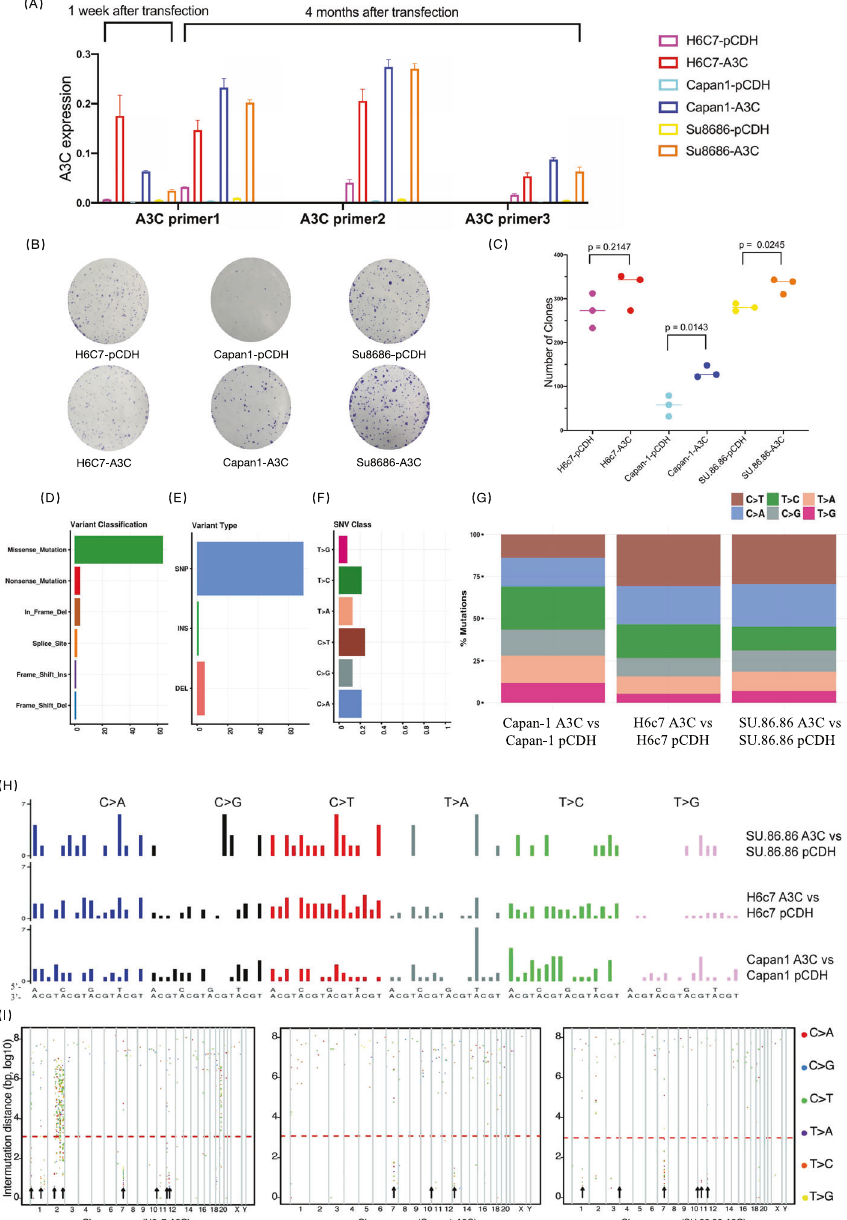
Fig. 4 Transfection of pCDH-APOBEC3C into pancreatic cell lines causes characteristic genomic alterations. A APOBEC3C-overexpressing cell lines were generated by transfecting a pCDH plasmid loaded with the APOBEC3C CCDS, and the control group was transfected with the pCDH backbone plasmid. Multiple APOBEC3C primer pairs were applied to perform qRT – PCR in triplicate at different time points after transfection to validate that the cell lines transfected with the pCDH-A3C plasmid had a steadily elevated APOBEC3C mRNA expression level compared to the corresponding control cell lines. The corresponding western blotting results are shown in Fig. S4. B Representative images of the clonogenic assay. The assay was repeated in triplicate. C Summary of clone counts for H6c7-pCDH (mean = 272.7, SD = 39.5), H6c7-A3C (mean = 322.3, SD = 42.91), Capan-1-pCDH (mean = 56.33, SD = 23.54), Capan-1-A3C (mean = 132.3, SD = 13.8), SU.86.86-pCDH (mean = 280.3, SD = 8.505) and SU.86.86-A3C (mean = 280.3, SD = 8.505) cells. Welch ’ s t -test was applied to perform statistical analyses and obtain a two-tailed p -value. D , E , F Classi fi cation of newly occurring variants in APOBEC3C-overexpressing cell lines. Missense mutation was the major variant type ( D ), SNV was more prevalent than INS and DEL ( E ), and C > T mutation was the primary SNV type ( F ). G Mutation spectrum of newly occurring SNVs in APOBEC3C-overexpressing cell lines compared to corresponding control cell lines. H Mutational signatures of newly occurring SNVs in H6c7, SU.86.86 and Capan-1 cells. The upper x -axis represents the nucleotide at the 5 ’ end fl anking the mutated sites, and the lower x -axis represents the nucleotide at the 3 ’ end fl anking the mutated sites. I Rainfall plots showing that some of the newly occurring SNVs in APOBEC3C-overexpressing cell lines had short intermutational distances and formed characteristic kataegis regions on chromosomes 1, 2, 3, 7, 11, 12, and 13. The x -axis represents the SNV position, and the y -axis represents the intermutational distance. The complete list of newly formed kataegis regions is recorded in Table S12. CCDS, consensus coding sequence; SNV/SNP, single-nucleotide variant/ polymorphism; INS, insertion; DEL,